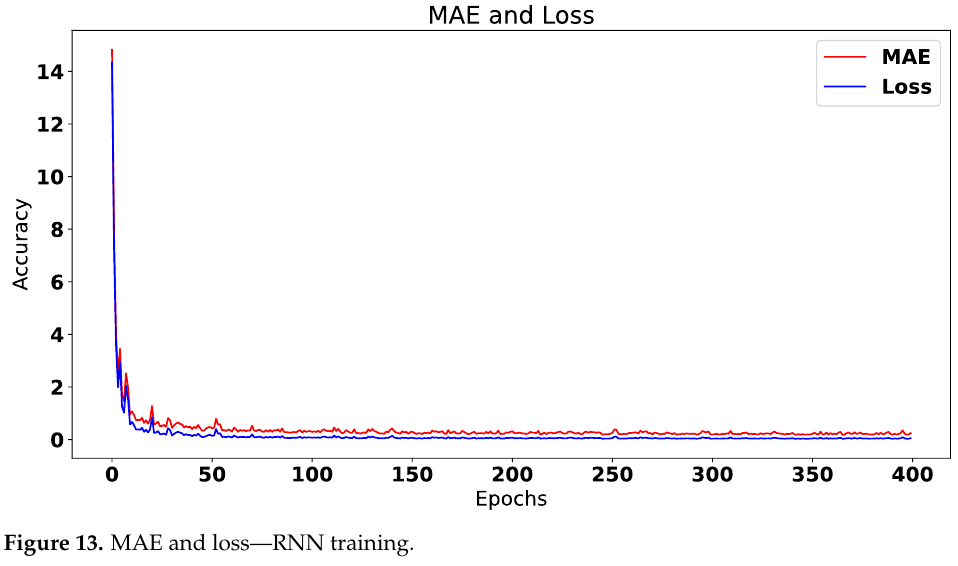
Figure 12. MAE and loss - LSTM training